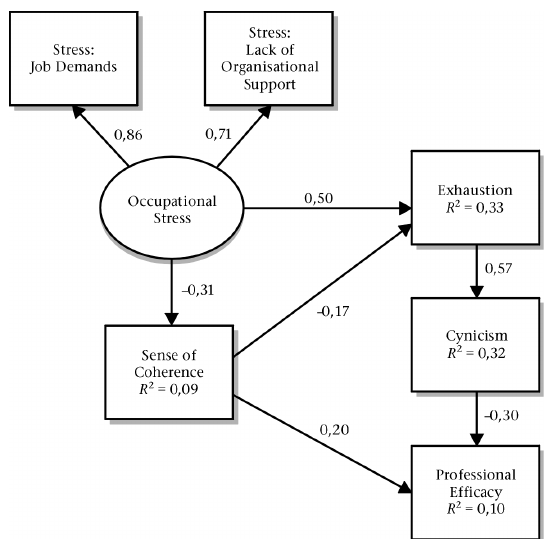
Figure 1. Maximum likelihood estimates for the burnout model, N = 270. Note. All factor loadings and path coefficients are significant at the p < 0,01 level As can be seen in Figure 1, the path from job stress to exhaustion is significant. This means that the higher the stress because of job demands and a lack of organizational support reported by employees, the higher their level of exhaustion. In addition, the path coefficients from sense of coherence to exhaustion and professional efficacy were significant. This means that the higher the sense of coherence, the lower the exhaustion and the higher the professional